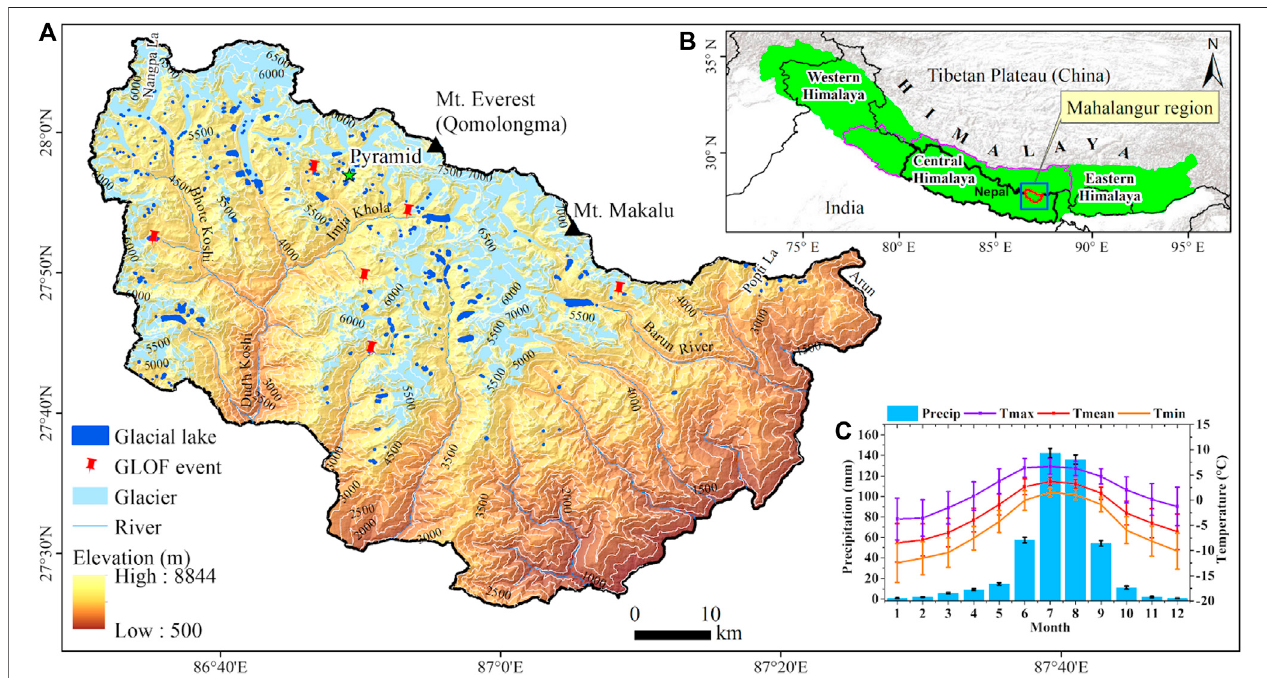
FIGURE1|(A) Map showing thespatial distribution ofglaciers,glaciallakesandhistorical GLOF eventsinthe Mahalangur region.The insets show (B) thelocation of the study area in the Himalaya (base map from ESRI) and (C) the annual monthly distribution of air temperature (1994 – 2013) and precipitation (1994 – 2016) obtained fromthehighelevationpyramid weatherstation(5,050 ma.s.l.).Theerrorbarsrepresent thestandarddeviation.TheboundaryoftheHimalaya isadaptedfromNieetal.